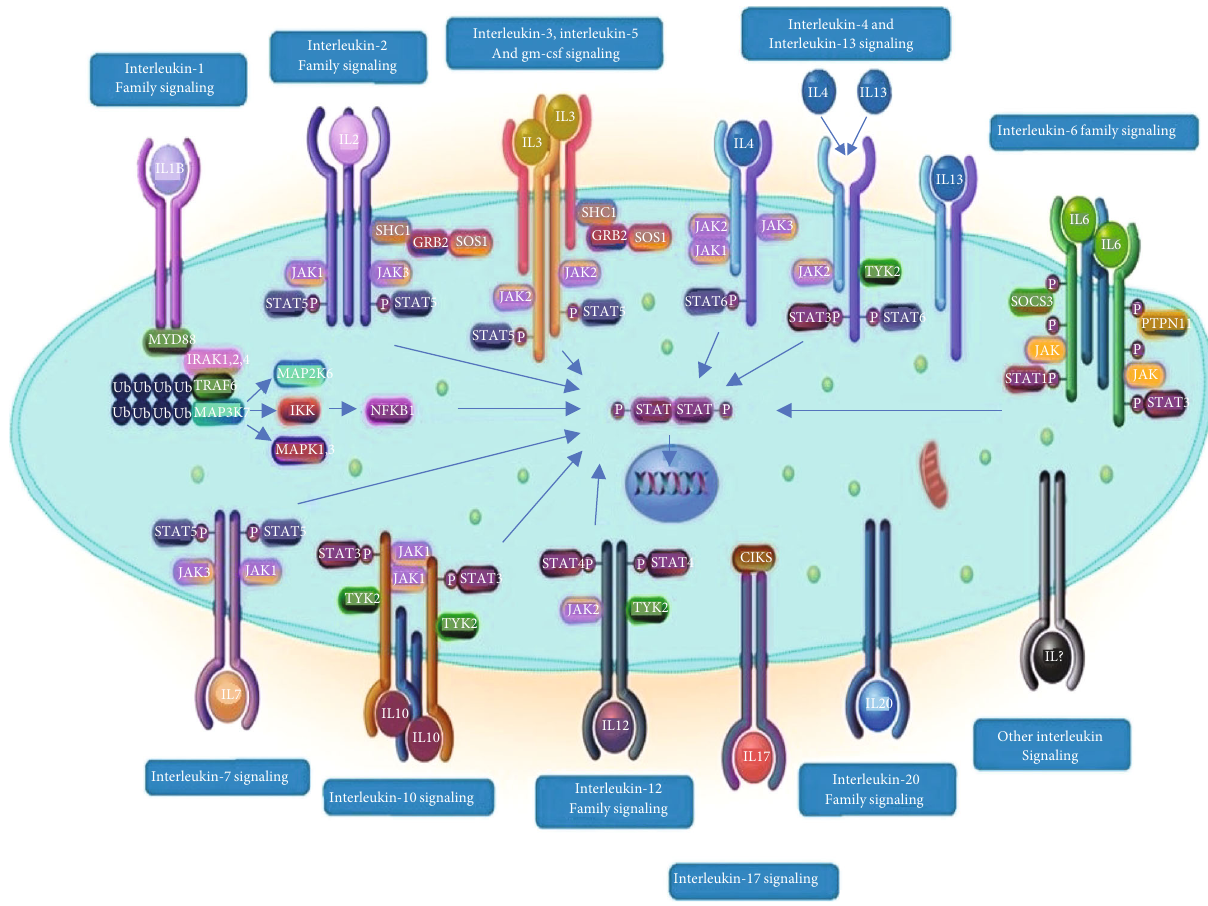
Figure 1: A schematic fi gure of low molecular weight of interleukins bound to their speci fi c receptors located upon the cell membrane which induce di ff erent signaling pathways (https://reactome.org/PathwayBrowser/#/R-HSA-449147) [69, 70]. Janus kinase 1 (JAK1); Tumor necrosis factor (TNF); Signal transducer and activator of transcription (STAT); Phosphorylated STAT (pSTAT); TNF receptor- associated factor 6 (TRAF6); Mitogen-activated protein kinase 14 (MAPK14); c-Jun N-terminal kinases (JNKs); Extracellular signal- regulated kinases (ERKs); Mitogen-activated protein kinases (MAPKs); Phosphatidylinositol 3-kinases (PI3Ks); Granulocyte-macrophage colony-stimulating factor (GM-CSF); Pulmonary alveolar proteinosis (PAP); Suppressor of cytokine signals (SOCS); Protein Tyrosine Phosphatase Nonreceptor Type 11( PTPN11 ); Cytosolic adaptor molecule ACT1 (also known as CIKS); Tyrosine Kinase 2 ( TYK2 ); IL1R- associated kinase (IRAK); SHC Adaptor Protein 1(SHC1); Growth factor receptor-bound protein 2 (GRB2); IkappaB kinase ( IKK ); Myeloid di ff erentiation primary response 88 ( MYD88